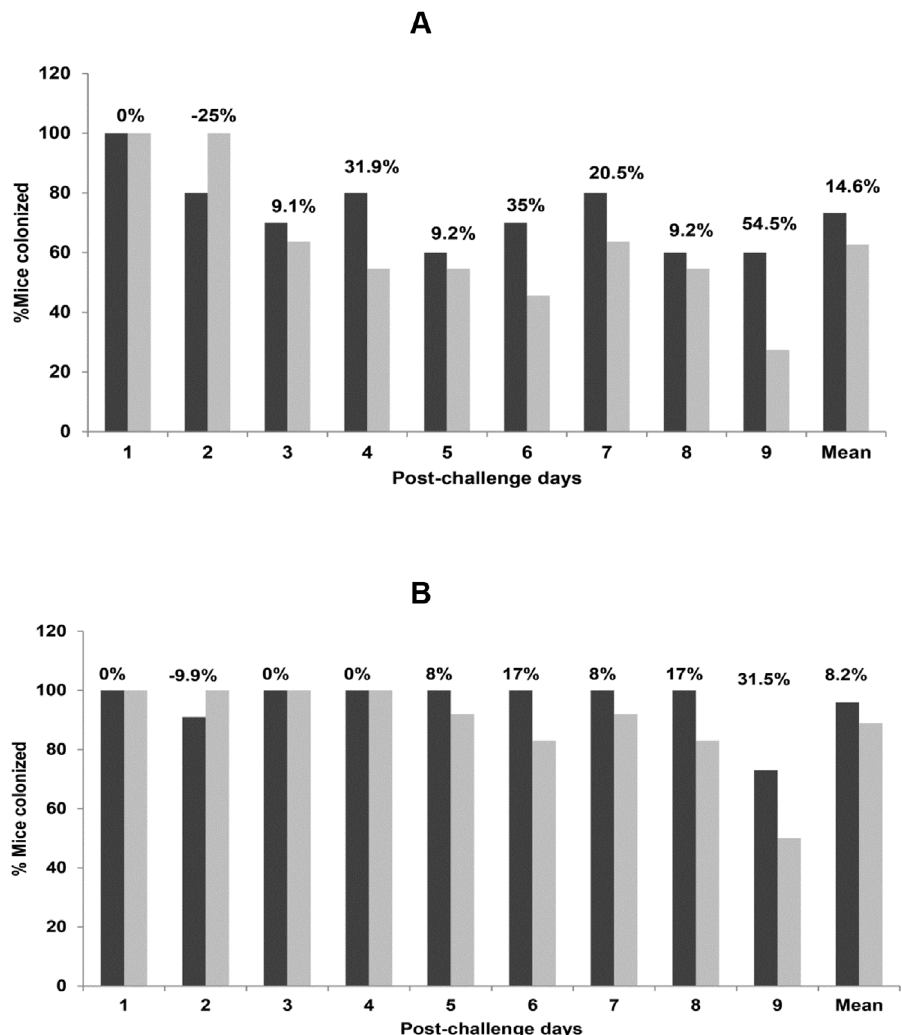
Fig 2. Colonization of mice by C . jejuni 48 (A) and by C . jejuni 111 (B). The X-axes represent post- challenge days and the Y-axes indicate % colonization. “ Mean ” is the mean value for all 9 days. No statistical difference in colonization was seen between the dmLT-vaccinated (light bar) and control (dark bar) mice for both strains. The protective efficacy of the vaccine for each day is shown above the corresponding bars.